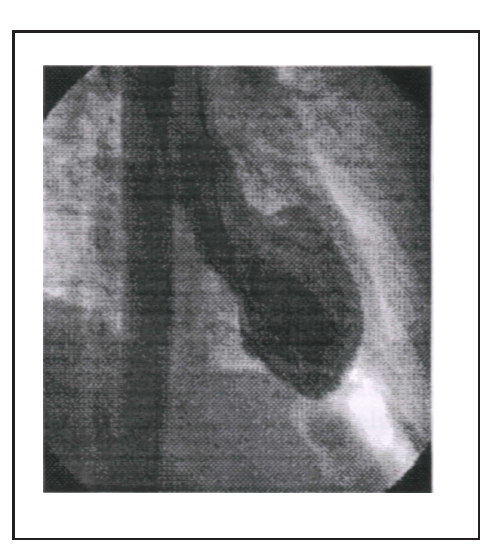
Fig.2: Left ventriculogram - apical ballooning (Systole) Fig.3: